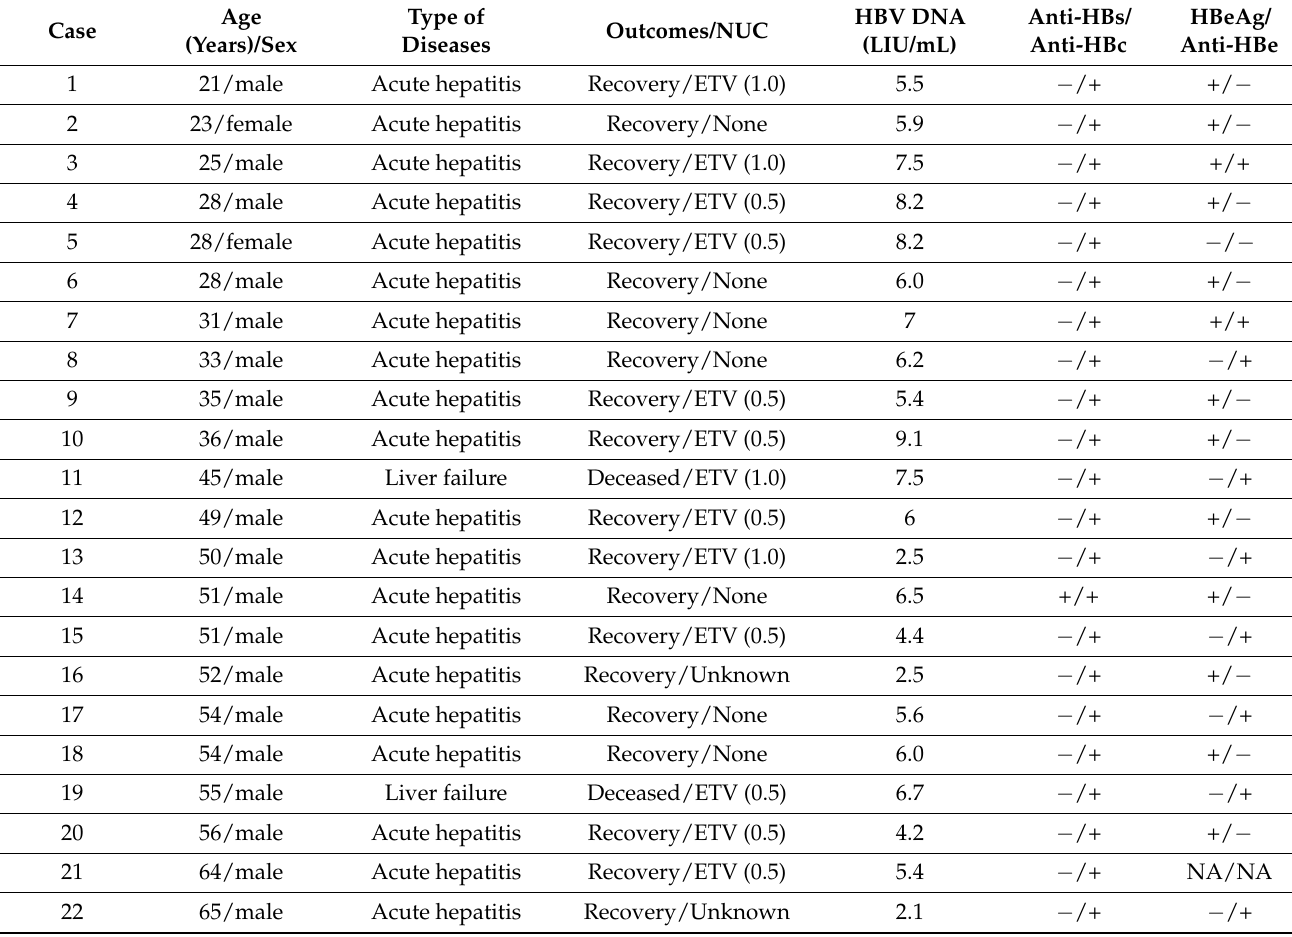
Table 2. Highly suspected hepatitis B virus (HBV) patients with HBV surface antigen (HBsAg)-positivity and alanine transaminase (ALT) elevations higher than 1000 IU/L.